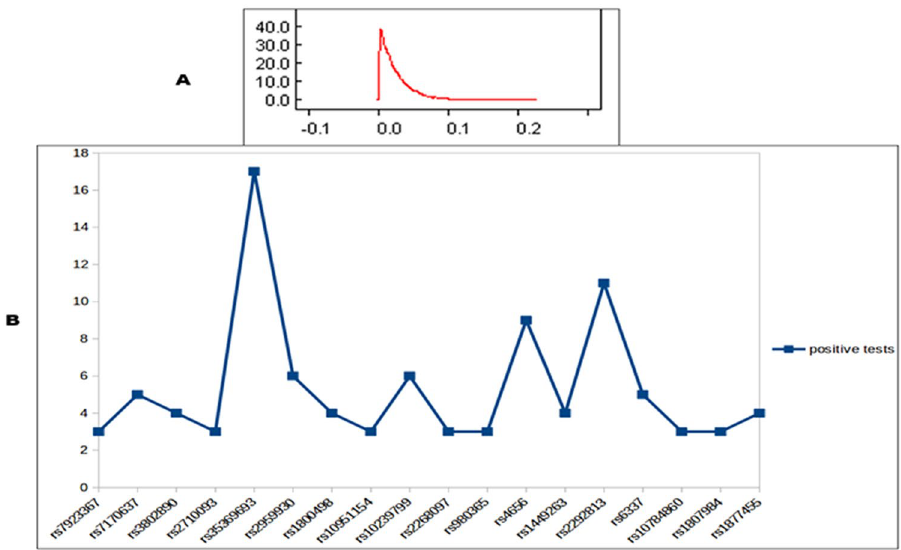
Figure 1. Bayesian conjugate beta-binomial analysis. ( A ) Posterior distribution obtained after 10,000 MCMC simulations. ( B ) Positive selection tests that crossed the minimum